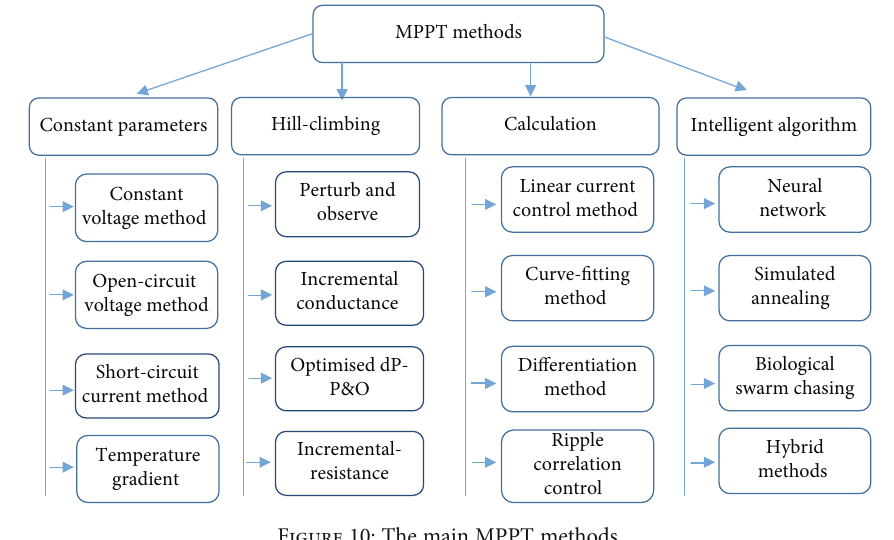
Figure 10: The main MPPT methods. Table 5: Comparison of annual energy generated by 1 kW PV